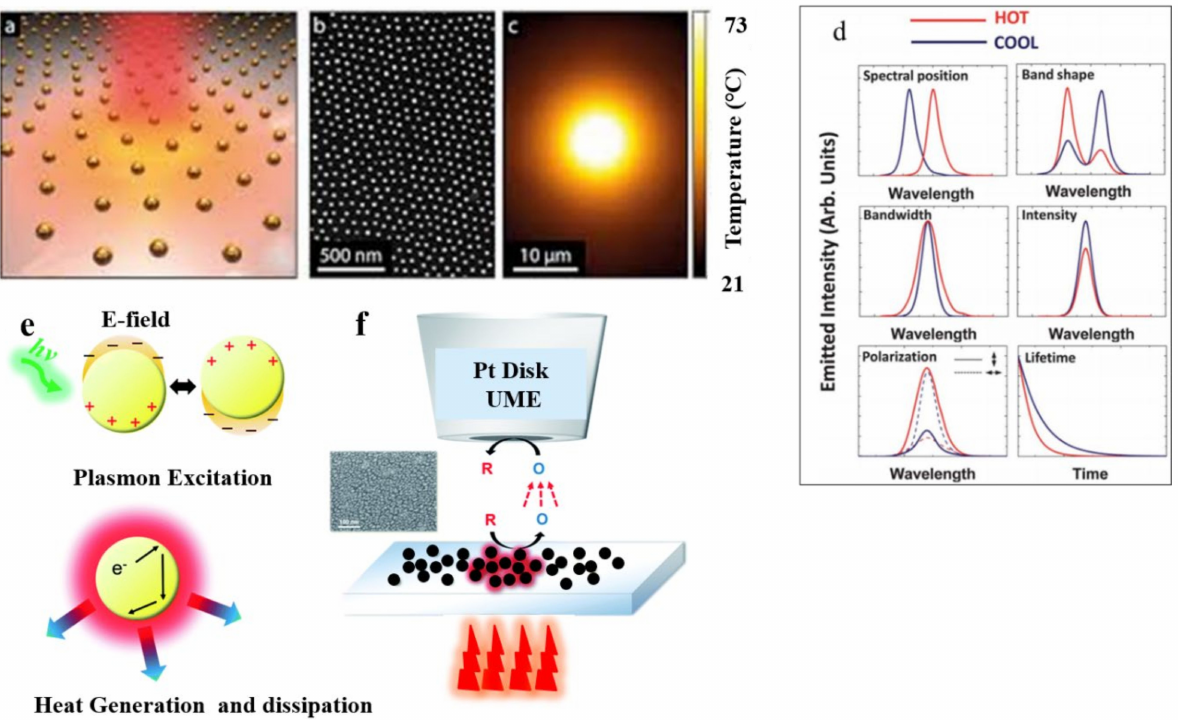
Figure 5. ( a ) Representation of glass decorated with gold nanoparticles. ( b ) SEM analysis of gold nanopar- ticles. ( c ) Gold nanoparticles after illumination temperature profile [77]. Reprinted with permission from [77], Copyright 2018, EDP Sciences. ( d ) Possible effects due to temperature increase are schematically represented. Effects due to temperature increase are depicted as red lines. ( e ) Presentation of (top) excited surface plasmons and (bottom) the resulting plasmonic nanoparticle surface temperature increase. ( f ) SECM setup with Au nanoparticles on a substrate, schematically depicted with an SEM image [75]. Reprinted with permission from [75], 2018, The Royal Society of